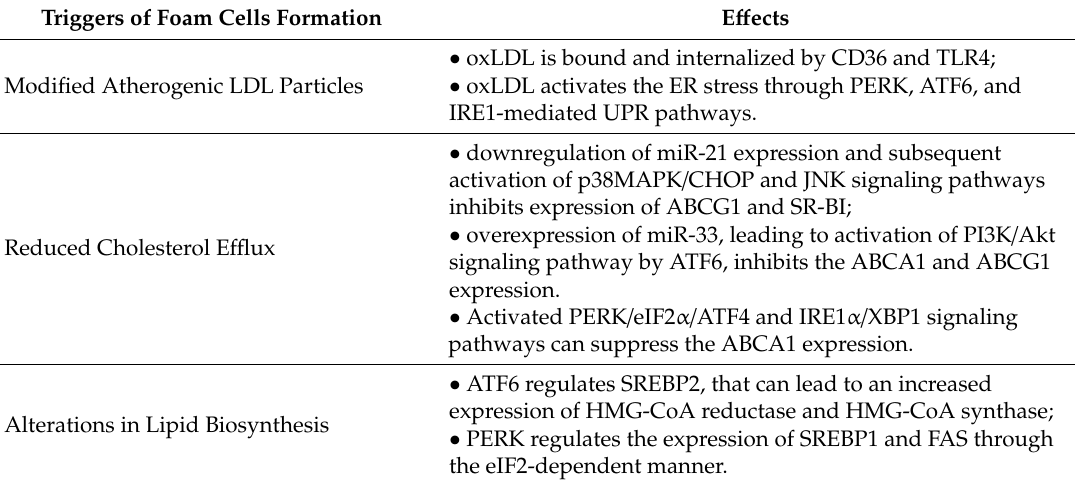
Table 1. Macrophage lipid accumulation under endoplasmic reticulum